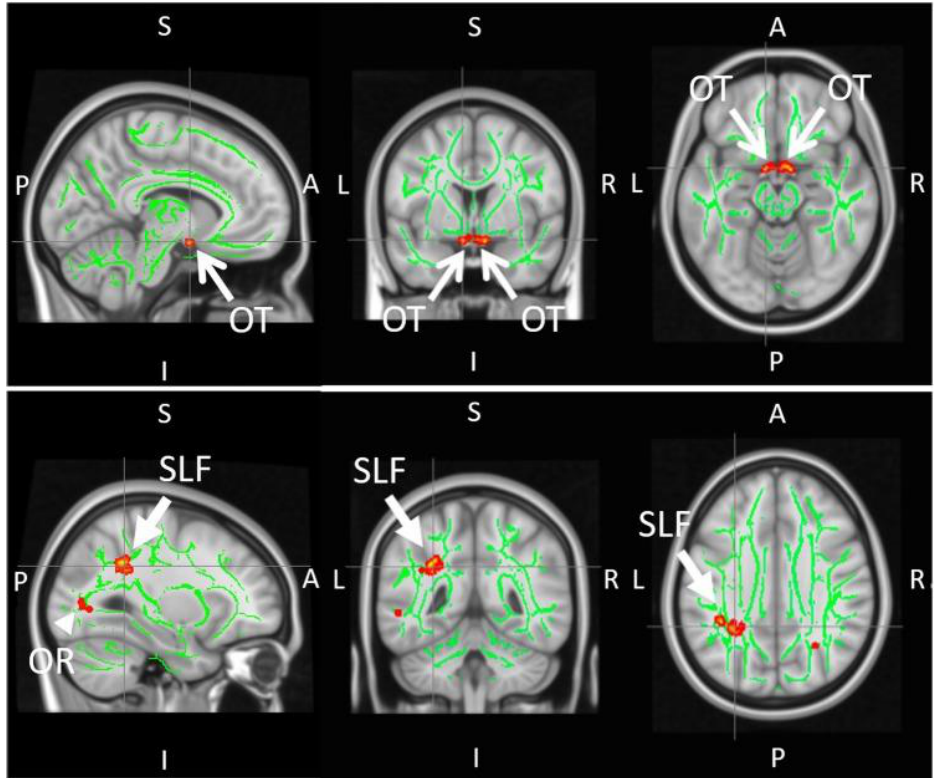
Figure 9. Tract-based spatial statistics (TBSS) of major white matter skeletons (green) demonstrating reduced FA (red and yellow pixels) in the optic tract (OT), optic radiation (OR), and the left superior longitudinal fasciculus (SLF) of early glaucoma patients as compared to healthy controls. Images are adapted with permission from Trivedi et al. [119].